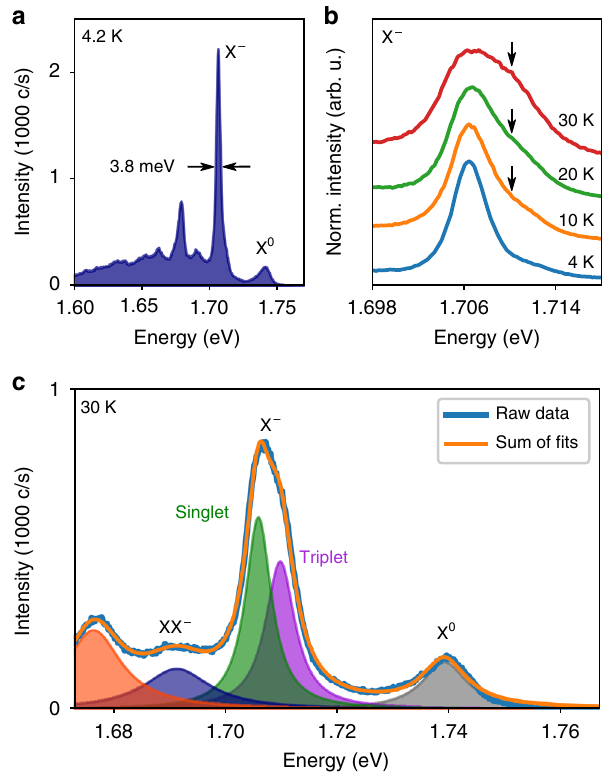
Fig. 2 Trion photoluminescence in WSe 2 . a Photoluminescence (PL) spectrum from the sample under non-resonant laser excitation at 4.2 K. Peaks attributed to the neutral A-exciton (X 0 ) and trion (X − ) can be seen. The trion linewidth is 3.8 meV. b Temperature dependence of the trion photoluminescence from 4.2 to 30 K. Increasing thermal population of the higher energy triplet states can be inferred from the increasing spectral weight of the high energy shoulder of the trion peak, indicated by the black arrows. c PL spectrum from the sample at 30 K, fi tted to fi ve lorentzian peaks corresponding to various optically active states. The trion peak is well fi tted to two peaks corresponding to the fi ne structure components, separated by ~4 meV. The navy blue peak may be the recently